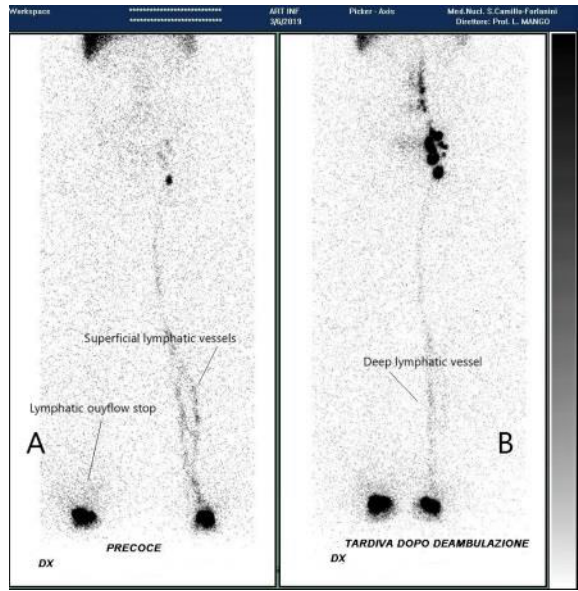
Figure 1. Lymphoscintigraphy of the limbs: ( A ) at time of injection ( B ) after 20 min